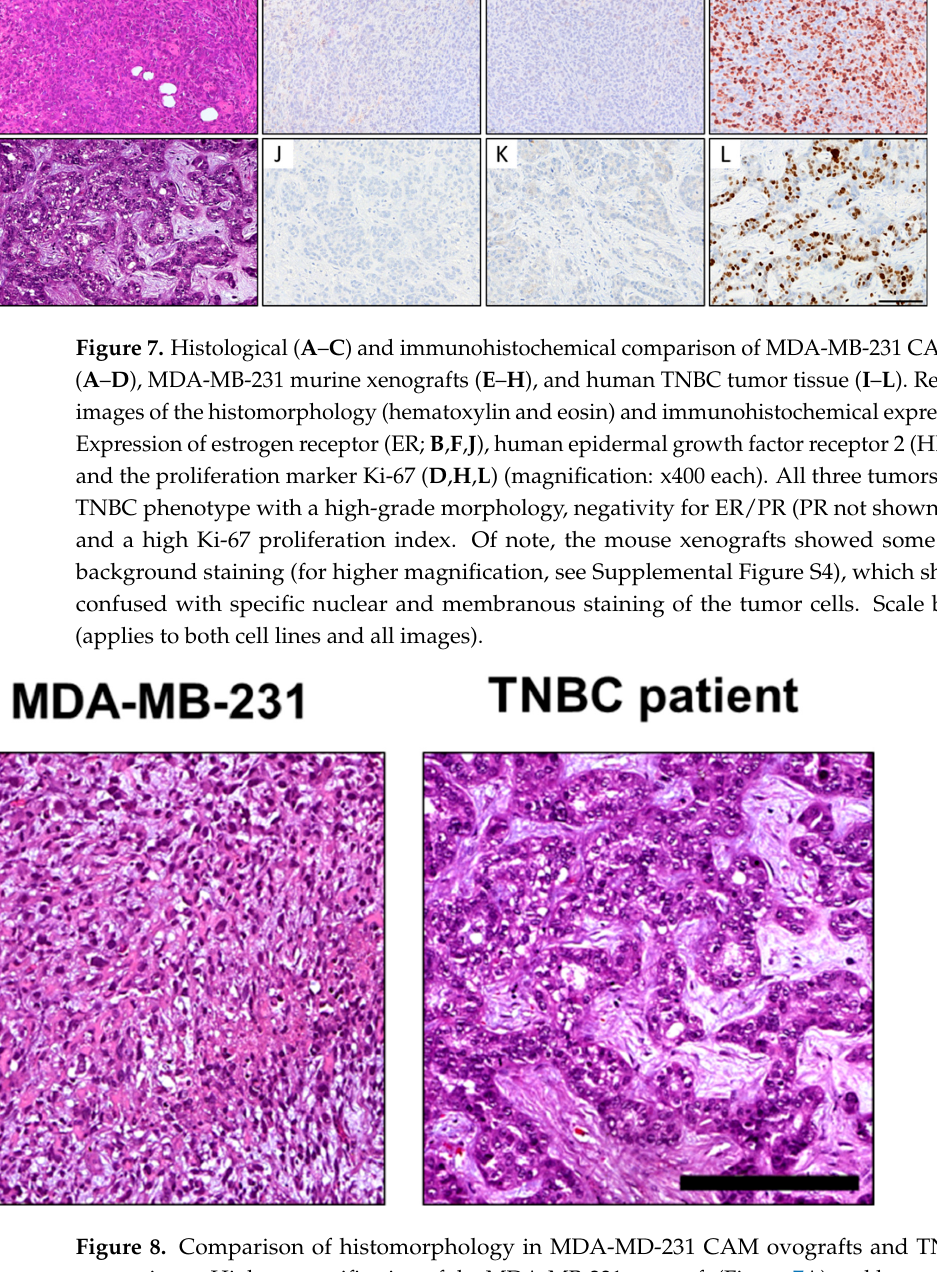
(ER/PR-positive, HER2-negative; Figure 9). The occurrence of both luminal subtypes was due to the varying tumor grade and Ki-67 proliferation index (median: 15.0%). The murine MCF-7 xenografts ( n = 2) showed an intermediate (G2) and poor tumor grade (G3) and a luminal B-like phenotype with ER/PR positivity, negative HER2 status, and a median Ki- 67 of 75.0%. However, the immunohistochemical assessment was hampered due to the unspecific background in the mouse xenografts (Figure 9E–H). When analyzing the human control cases, a hormone receptor-positive, HER2-negative status was confirmed by our central tumor grade and IHC; two cases presented luminal A-like tumors, and three presented luminal B-like breast cancer. Four cases were classified as invasive breast cancer NST, and one case was of the invasive lobular histological subtype with E-cadherin loss. The tumor grade was G2 in four cases and G3 in one sample. The median Ki-67 was 20.0%, which was close to the median proliferation rate of the MCF-7 ovografts.